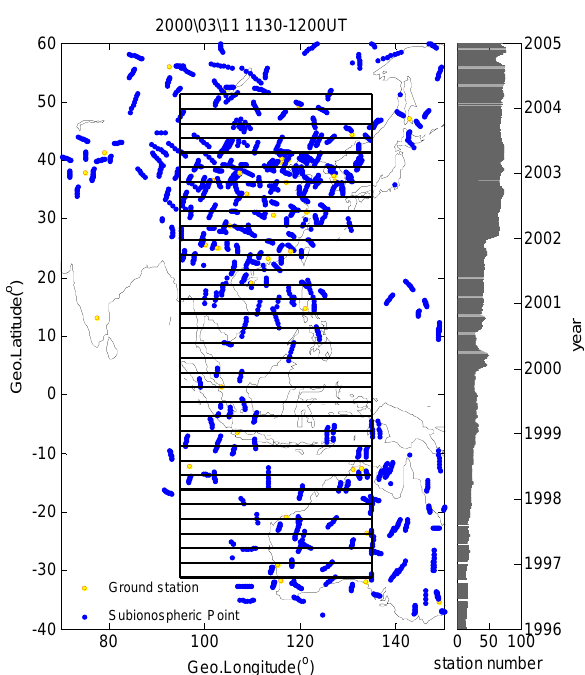
Fig. 1. Distribution of GPS receivers around Asian-Australian re- Figure 1 . Distribution of GPS receivers around Asian-Australian region. The dots represent gion. The dots represent the sub-ionospheric point track of the the sub-ionospheric point track of the GPS satellites during 1130-1200 UT on March 11, 2000. GPS satellites during 11:30–12:00UT on 11 March 2000. The area The area centered at 115° from 50.125°N-30.125°S was separated into 33 boxes with 40° centered at 115 ◦ from 50.125 ◦ N–30.125 ◦ S was separated into 33 width. By using least square fit and nearest neighbor interpolation method slant TEC boxes with 40 ◦ width. By using least square fit and nearest neigh- observations are converted to vertical TEC data of the corresponding box. bor interpolation method, slant TEC observations are converted to vertical TEC data of the corresponding